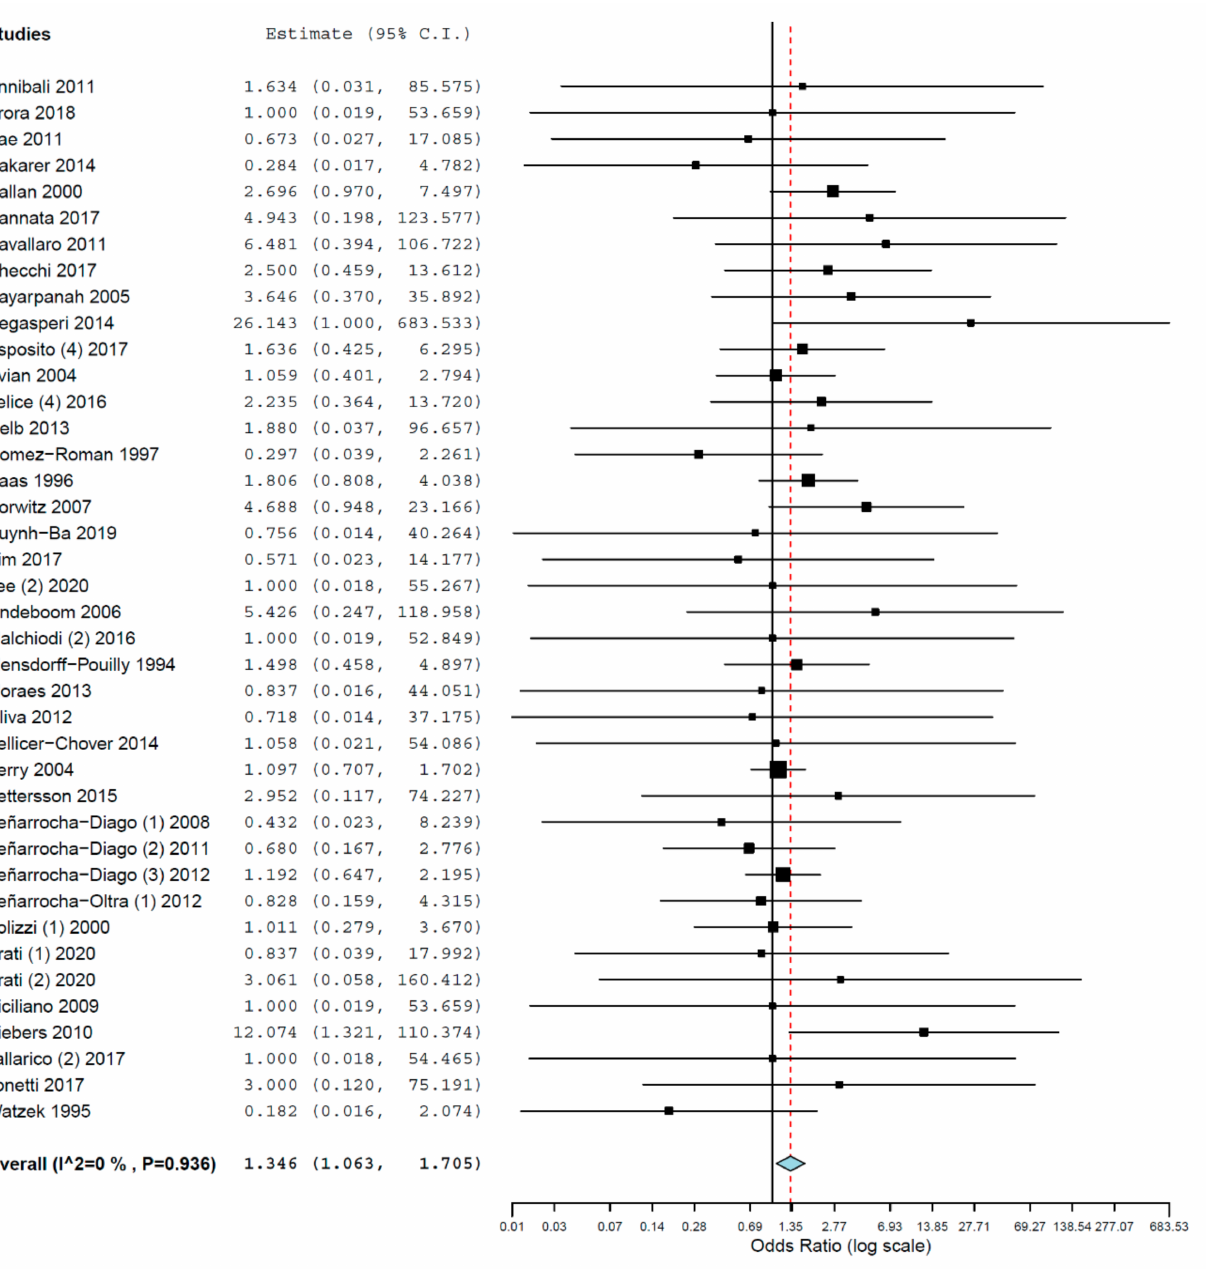
Figure 5. Forest plot for the event ‘implant failure’, studies evaluating implants with delayed loading exclusively. Estimate in Odds